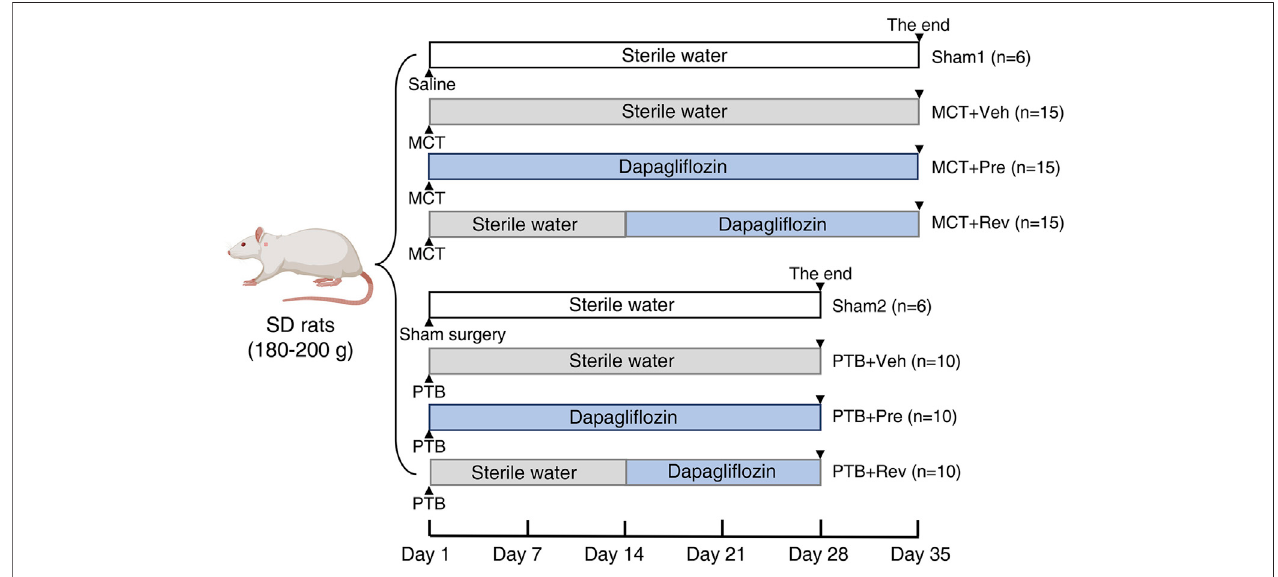
FIGURE 1 | Study design. In MCT study, rats were subcutaneous injected MCT (60 mg/kg) or equal volume of saline on Day 0. In PTB study, rats were performed PTB surgery or sham surgery on Day 0. Rats were administered dapagli fl ozin (1.5 mg/kg/day) or equal volume of sterile water by oral gavage.